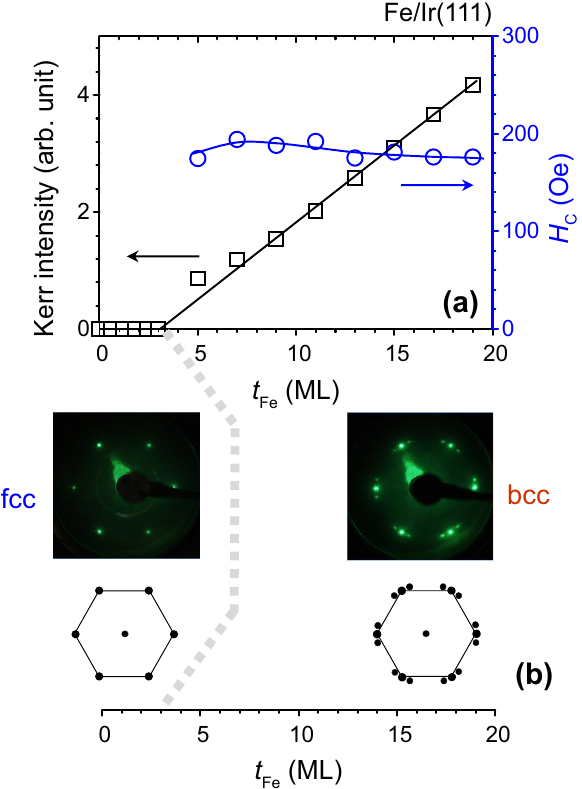
Figure 1. ( a ) Kerr intensity and coercivity versus Fe thickness in the longitudinal configuration. ( b ) LEED patterns for fcc-Fe and bcc-Fe at different thickness